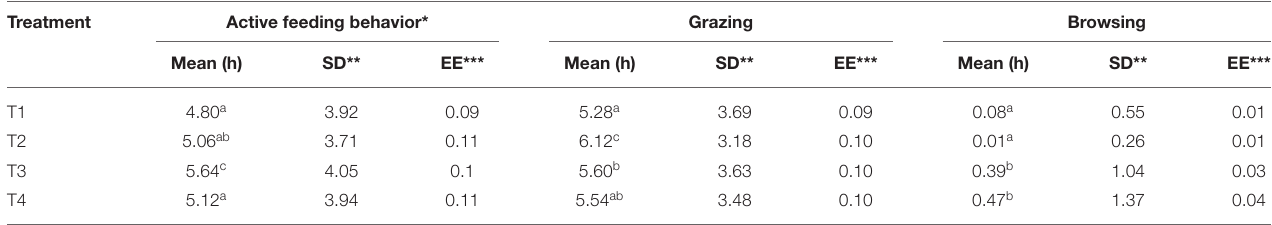
TABLE 6 | Time spent in active feeding behaviors.